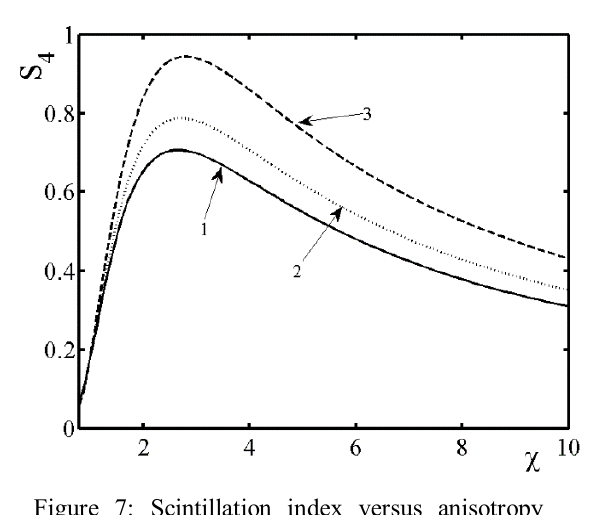
Figure 7: Scintillation index versus anisotropy factor for different orientation angle of anisotropic plasma inhomogeneities.